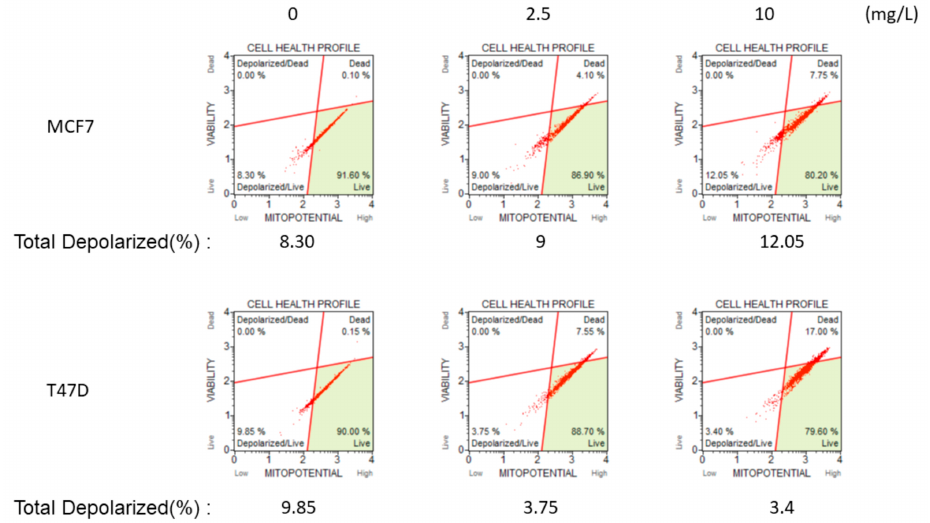
Figure A1. Using mitochondrial membrane potential experiment to observe the mitochondrial function of MCF-7 and T-47D breast cancer cell lines administrated with o-GQD for 72 h.